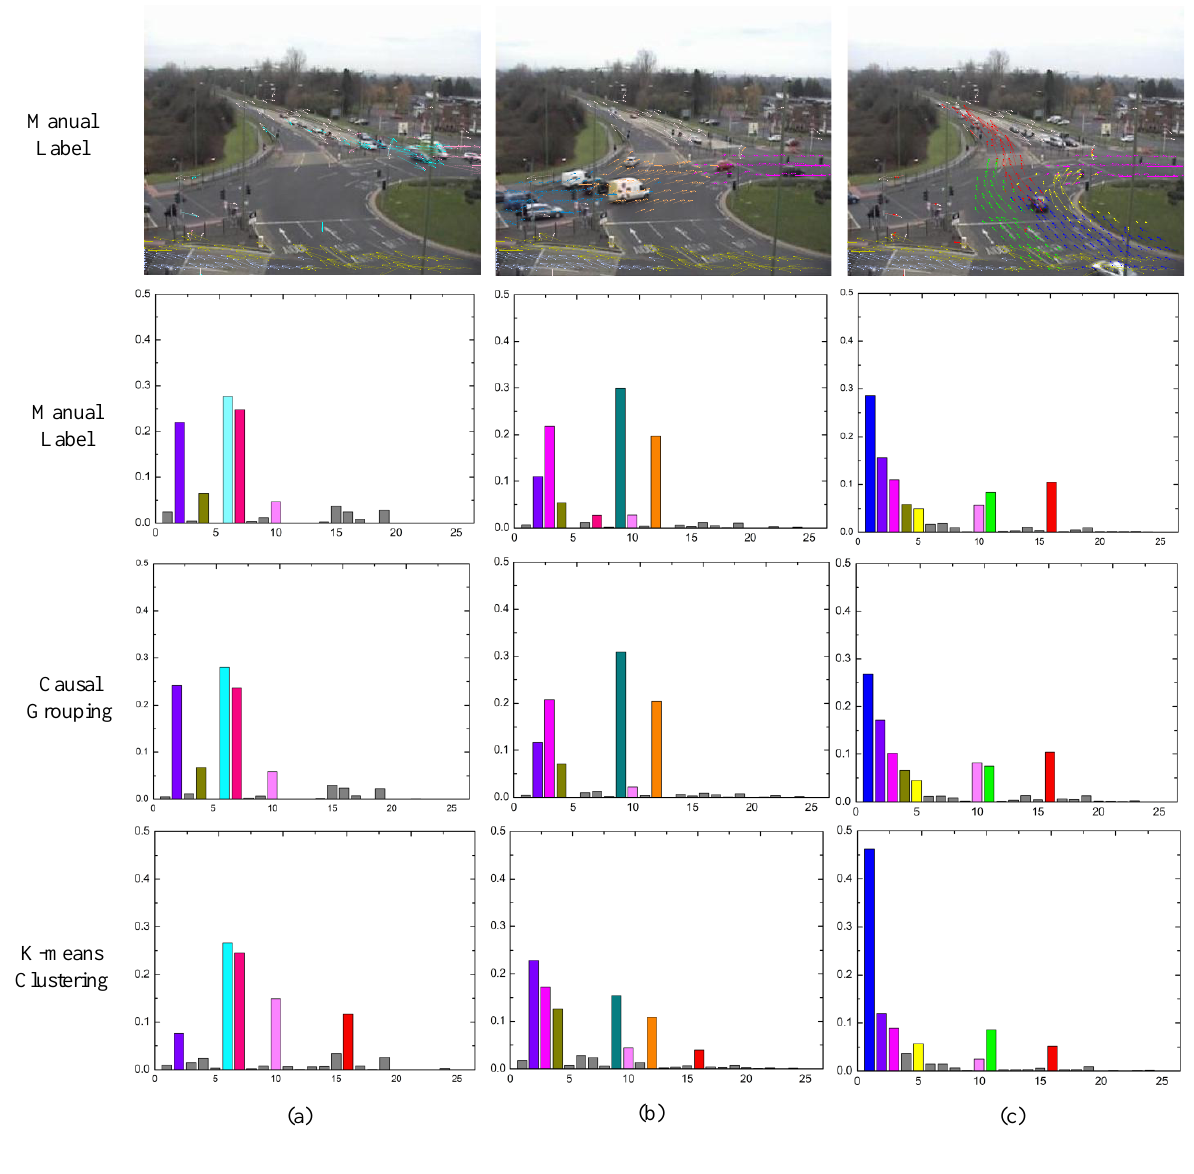
Figure 15. The topic distributions for the roundabout dataset. The short video clips are grouped into three clusters. Different colors indicate the different topics